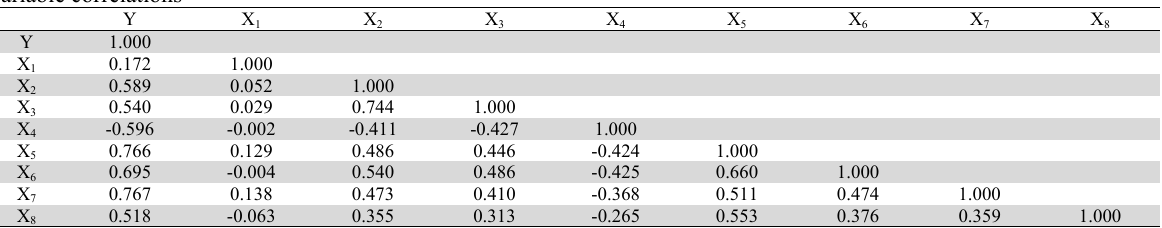
Variable correlations